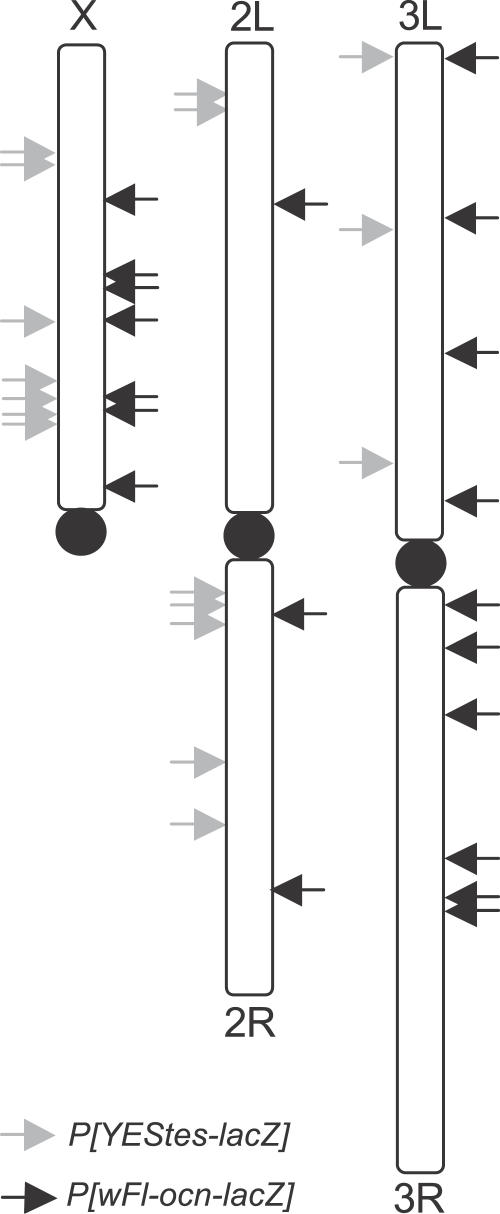
Chromosomal Location of the Transgene InsertionsArrows indicate the insertion sites of P[wFl-ocn-lacZ] (black) and P[YEStes-lacZ] (gray) transgenes as determined by inverse PCR. Nine additional inserts could be assigned only to the X chromosome or autosomes by genetic crosses and are not shown.